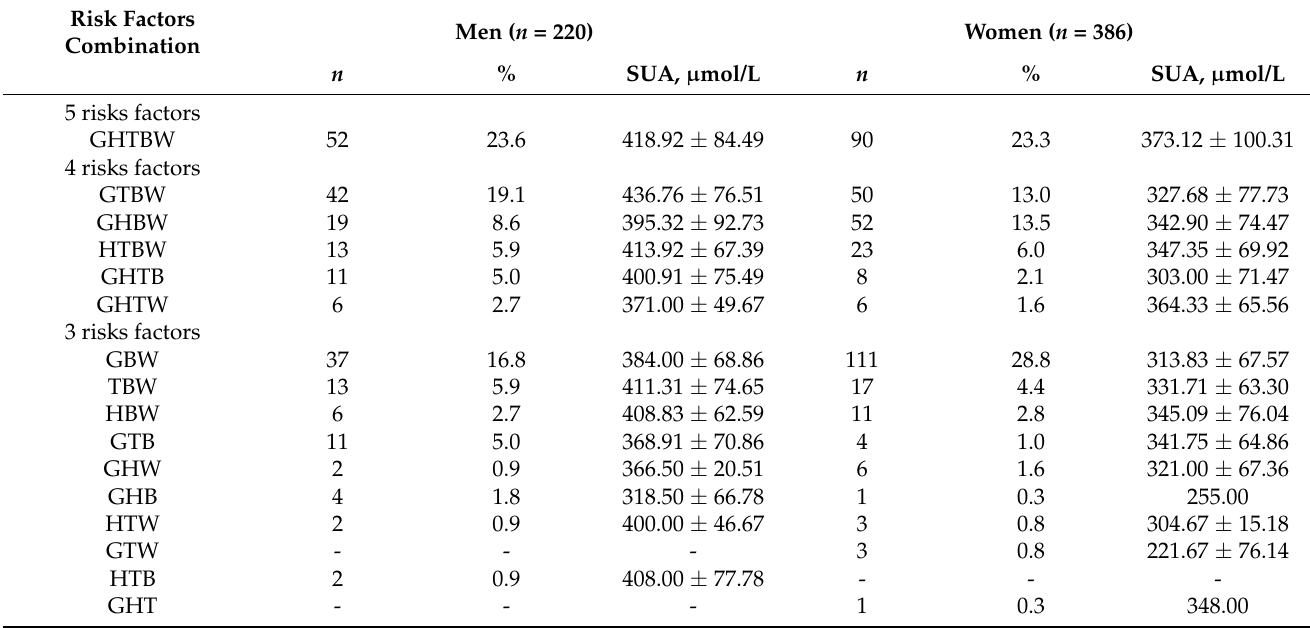
Table 2. Prevalence of clusters of MetS components and SUA.